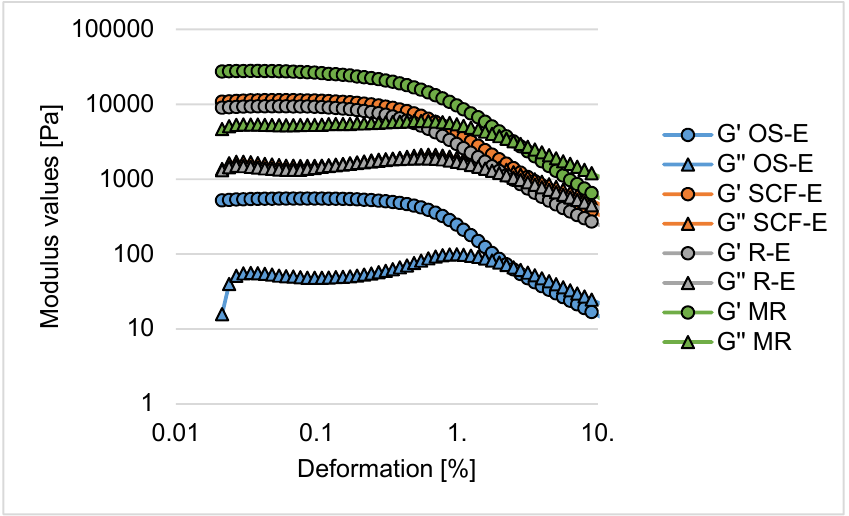
Figure 5. Amplitude sweep of gels stabilised by different types of birch bark extract.